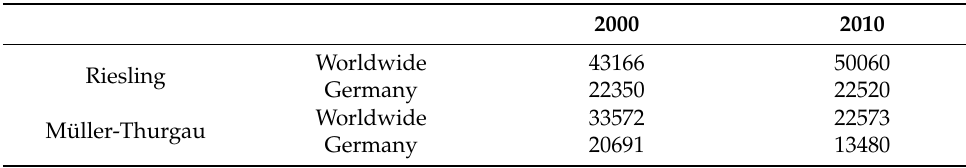
Table 1. Area (ha) under vines for Riesling and Müller-Thurgau